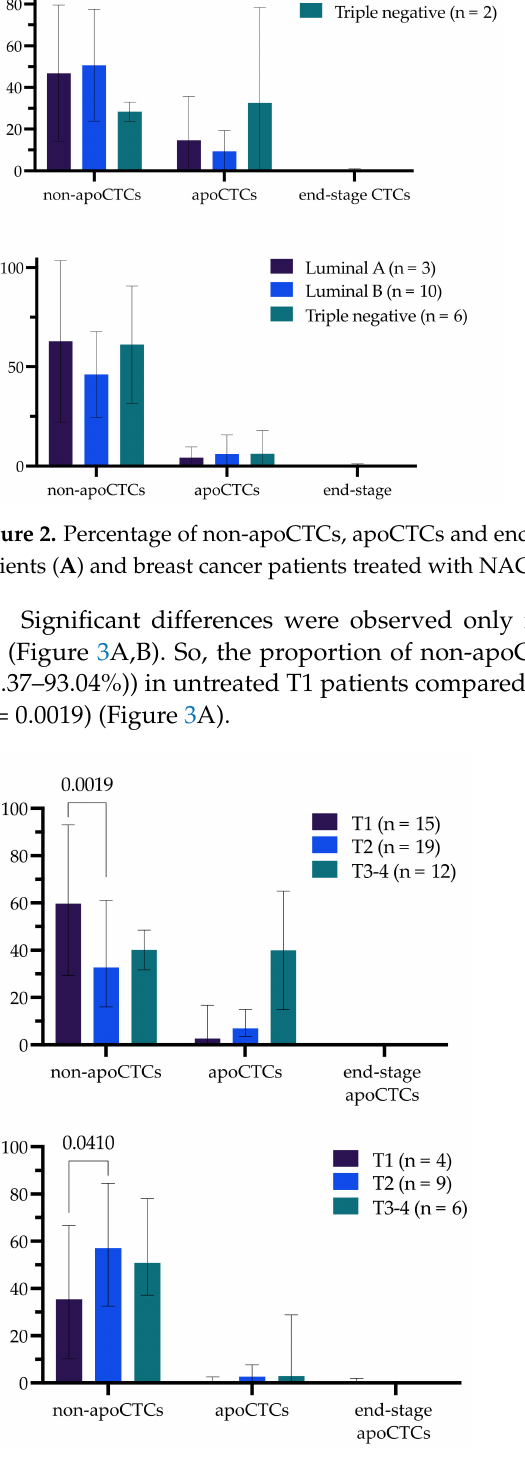
Figure 3. Percentage of non-apoCTCs, apoCTCs and end-stage apoCTCs in untreated breast cancer patients ( A ) and breast cancer patients treated with NAC ( B ) with different tumor sizes (T). While in patients treated with NAC, there was a controversial pattern, the pro- portion of apoCTCs was higher in T2 (57.14% (32.57–84.58%)) compared to T1 (35.47% (10.27–66.67%)) breast cancer patients ( p = 0.0410) (Figure